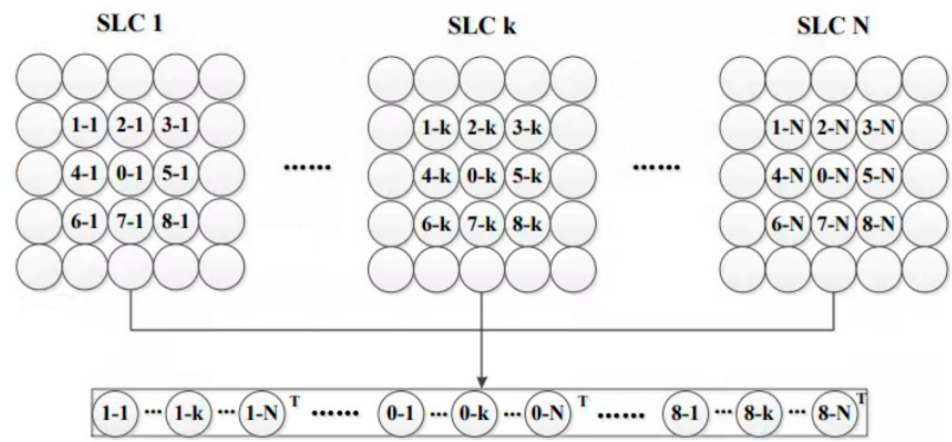
Figure 4. Joint-scatterer model for window with 3 × 3.